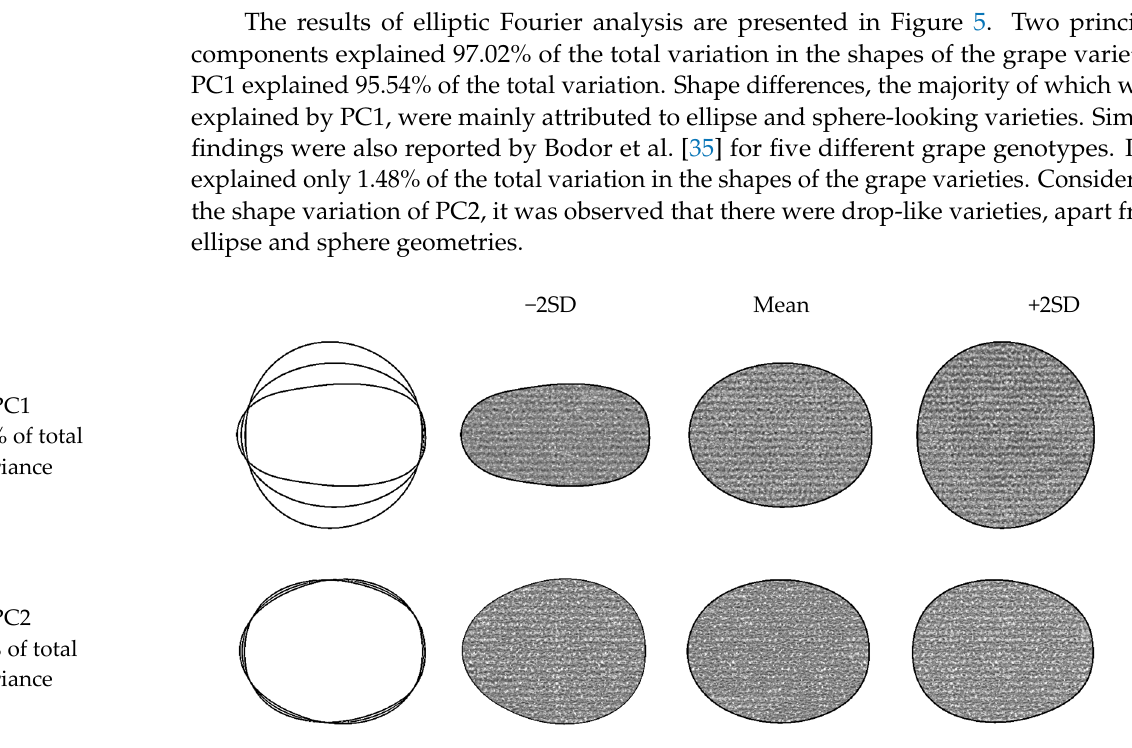
Figure 5. Principal components (PCs) for shape variables of grape varieties, based on a principal component analysis of 800 fruit outlines. From left to right, the outlines show the principal component scores corresponding to: mean − 2 standard deviations, mean, and mean +2 standard deviations.